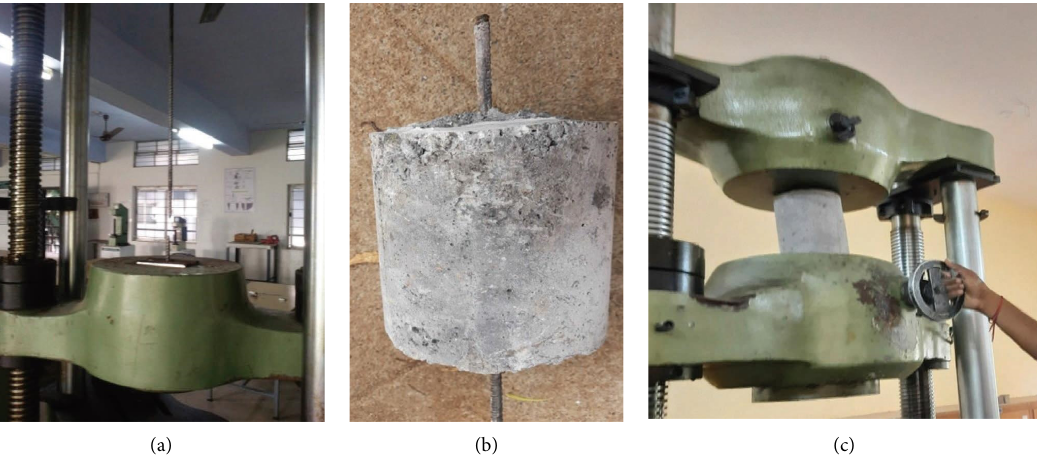
Figure 5: Testing of specimens: (a) tensile strength test of rebar, (b) specimen preparation for pull-out strength test, and (c) pull-out strength